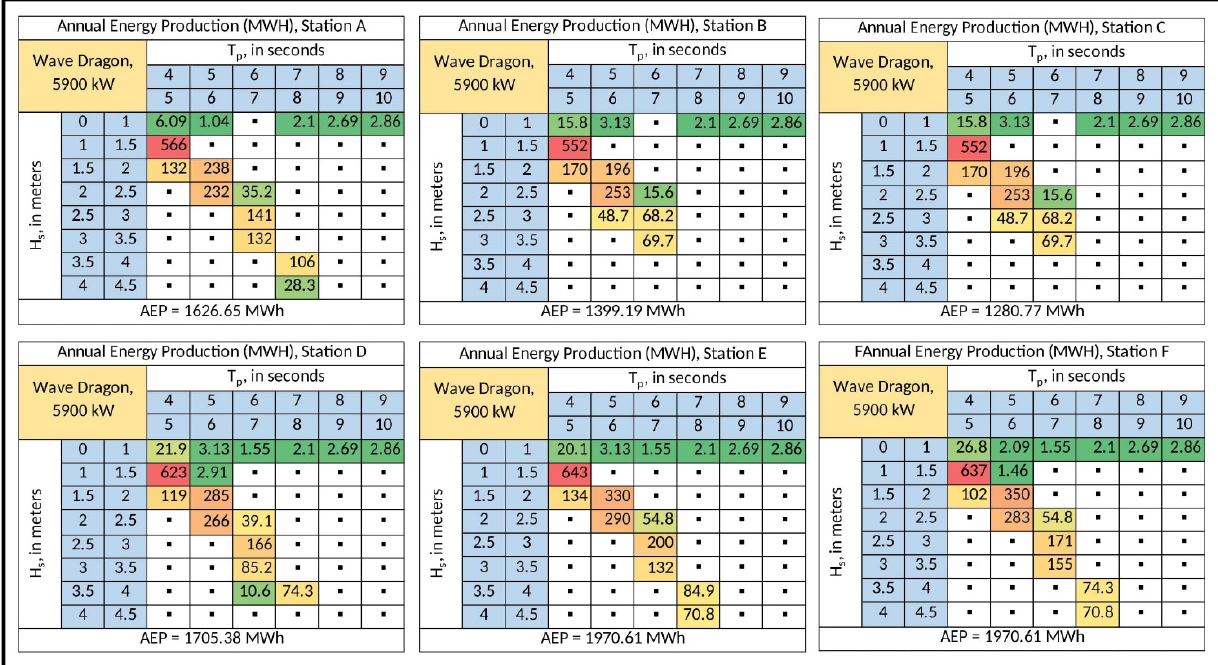
Figure A4. AEP computations of WD5.9 at stations A–F.